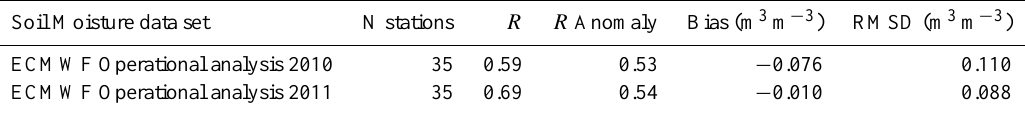
Table 4. Statistical scores for the comparison between ECMWF operational soil moisture analysis for 2010 and 2011. The new bare ground evaporation formulation was implemented in November 2010. Only stations where the model has a fraction of bare ground greater than or equal to 0.2 were used.